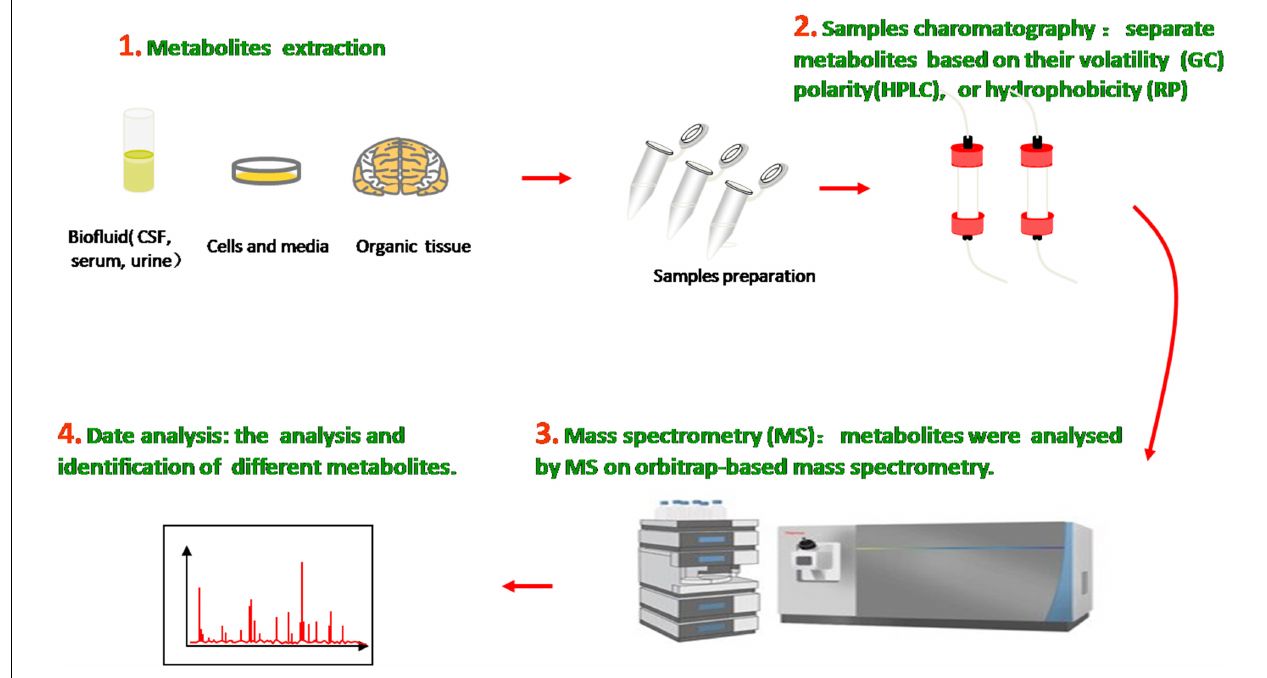
FIGURE 1 | Metabolomics analysis methods. Molecular metabolites were extracted from different samples, ranging from ionic compounds in cell lysates to various organic compositions in plasma, cerebrospinal fluid (CSF), urine, and tissue. Samples chromatography and mass spectrometry were prepared and administrated for analysis and